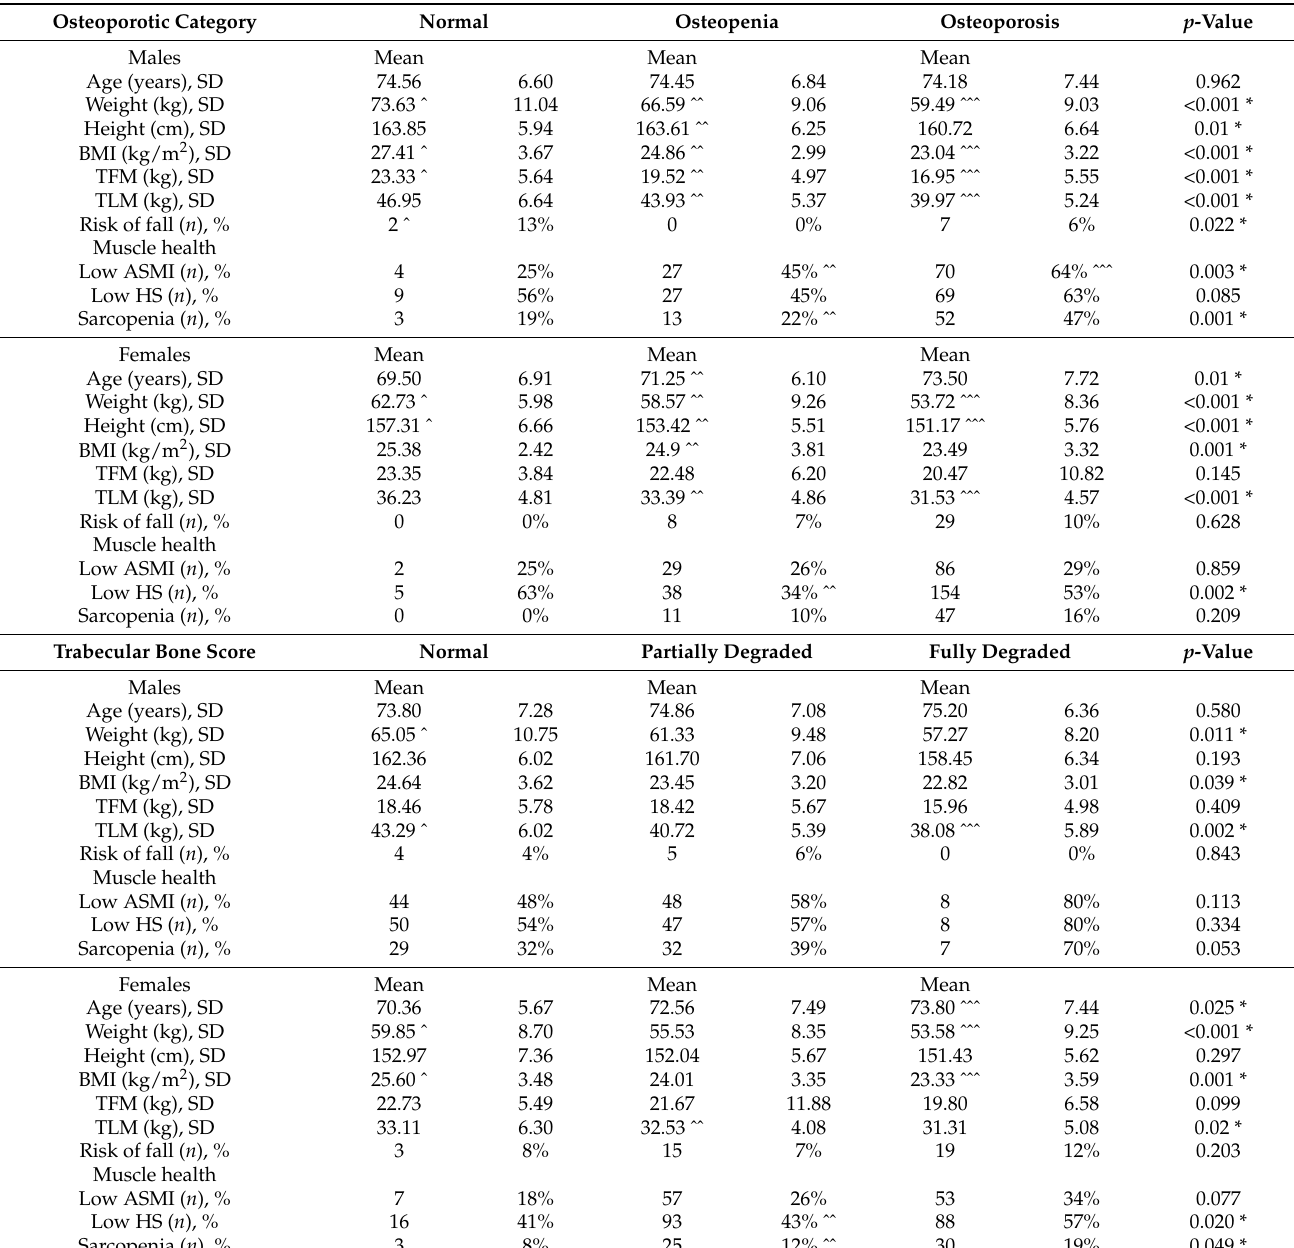
Table 2. The associations of body composition with bone quality and